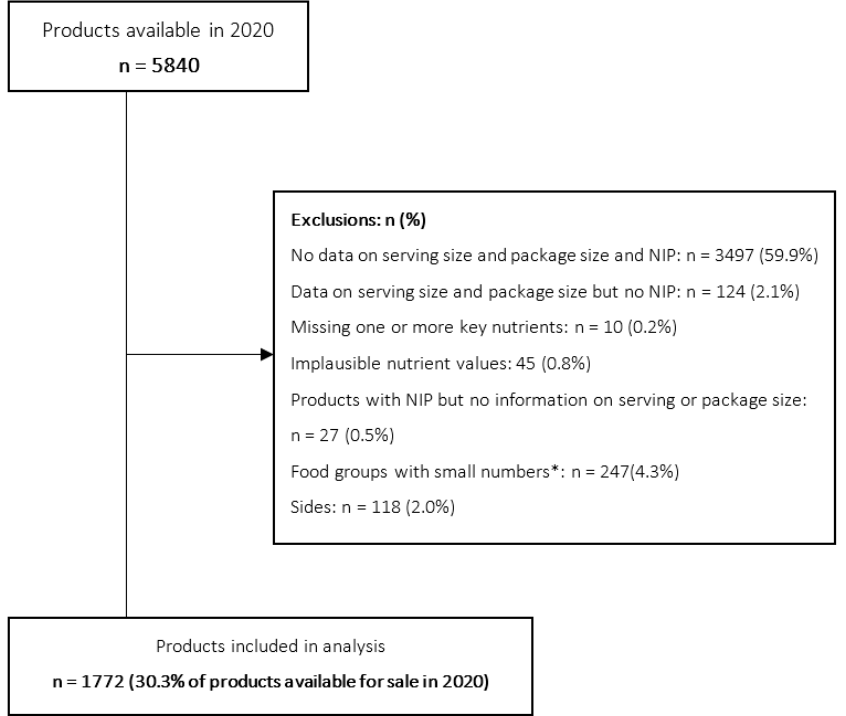
Figure 1. Flow-chart indicating the reasons and number of fast-food products excluded and included in the analyses, New Zealand, 2020. *Asian—Chinese, juice, beverages other, tea/coffee/hot chocolate, water, breakfast sweet, dressings/condiments sweet, other, seafood, soups.